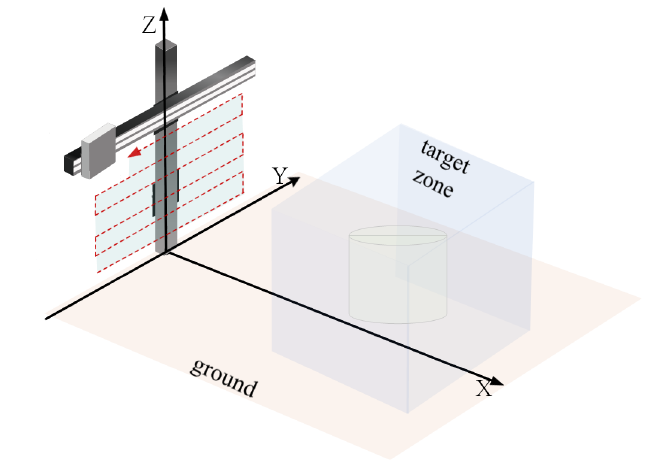
Figure 1. The measurement